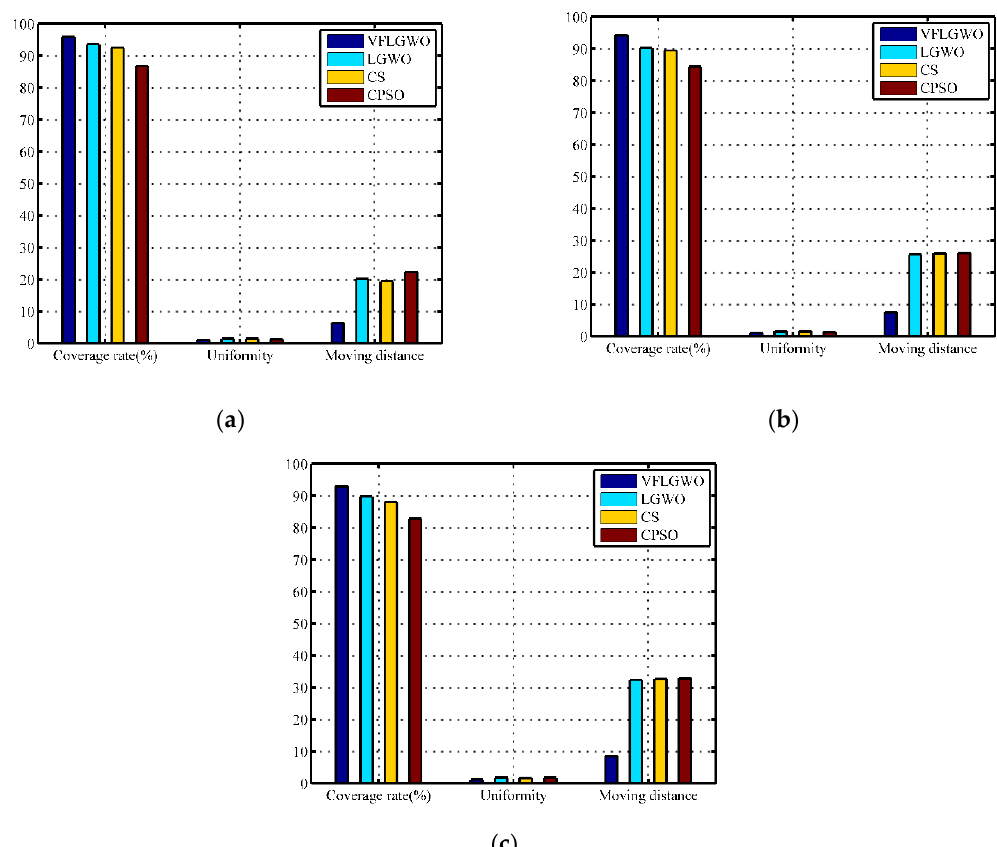
Figure 8. Performance index of four algorithms in different size monitoring areas. ( a ) 40 m × 40 m, ( b ) 50 m × 50 m, ( c ) 60 m × 60 m.